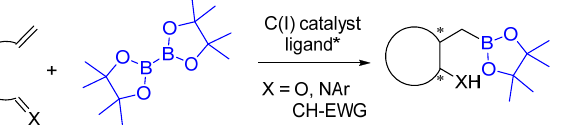
Figure 1. Copper-catalyzed intramolecular borylative coupling. (ligand* = chiral ligand).